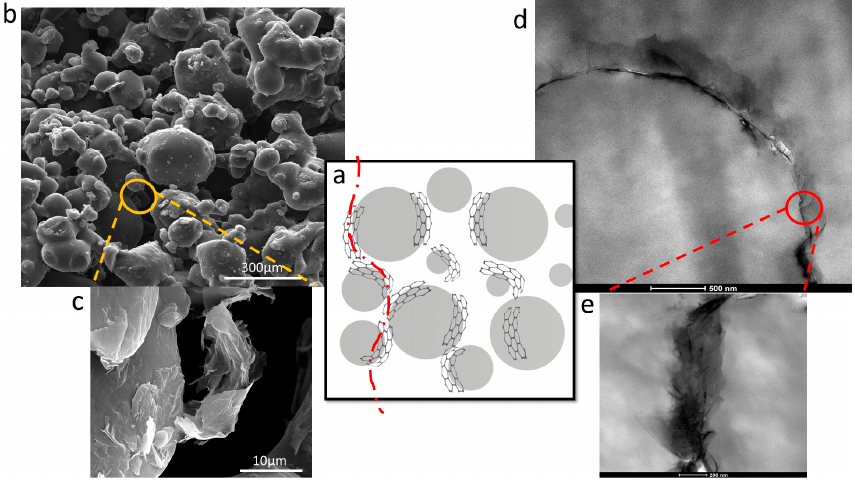
Figure 3. ( a ) Schematics of the microstructure of the fabricated porous TPU/GE composites (GE content 1.0 wt%), highlighting the percolated GE network at the interparticle boundary (red dashed line). SEM images of the ( b ) wall structure of the composite, and the ( c ) GE-wrapped TPU particle surface. ( d , e ) TEM images of the percolated GE network in the SLS-processed